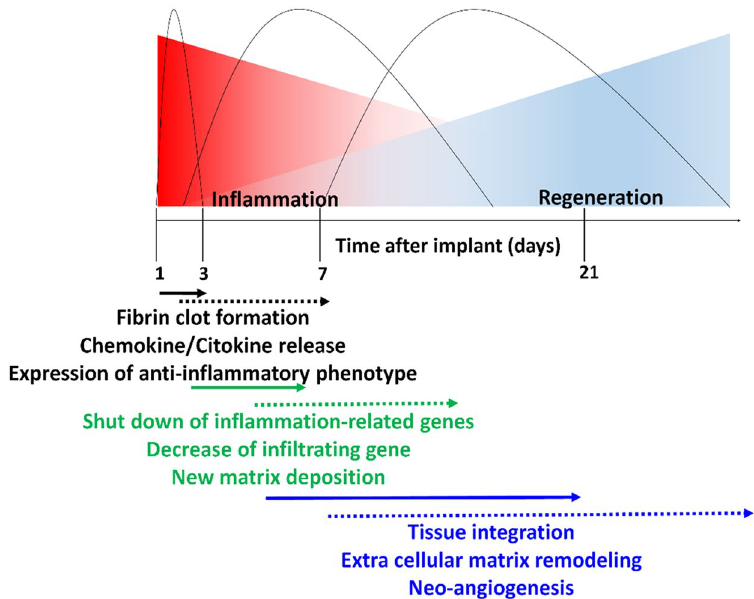
Figure 8. Schematic description of the regenerative events induced by the CS functionalization (hard line). The presence of CS results in the anticipated occurrence and shorter duration of the cascade of events following scaffold implantation. The dotted line shows the established wound healing